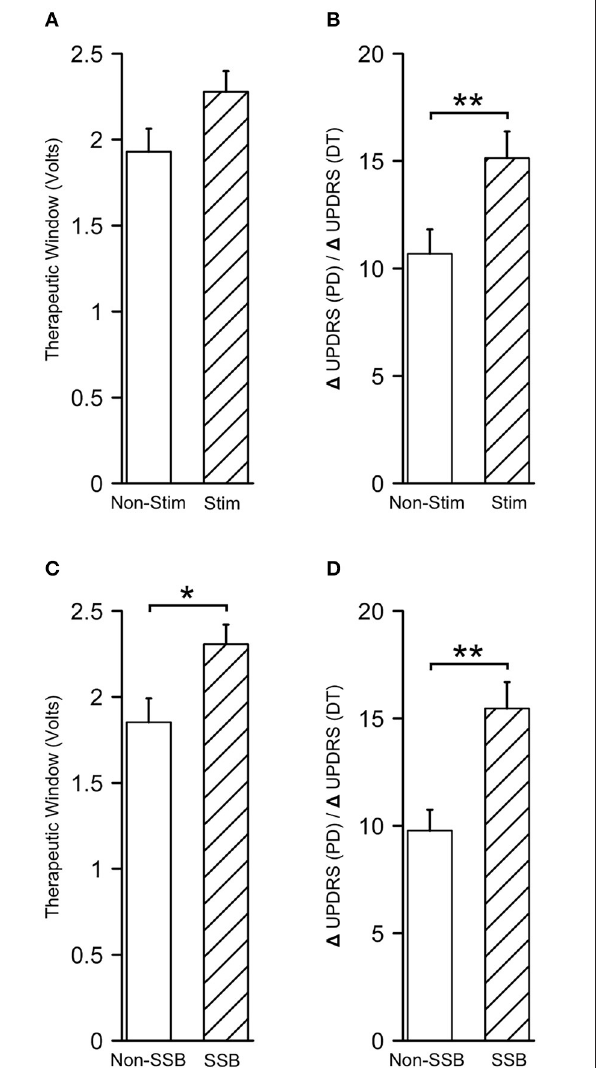
FIGURE 8 | Microstimulation contributes to better therapeutic effectiveness. (A,B) Therapeutic windows and differences in UPDRS/UDRS scores between the preoperative and intraoperative assessments ( 1 UPDRS/ 1 UDRS) in tracks with and without microstimulation. (C,D) Therapeutic windows and 1 UPDRS/ 1 UDRS scores in the SSB and non-SSB tracks. SSB, boundary between subthalamic nucleus and substantia nigra. * P < 0.05; ** P <